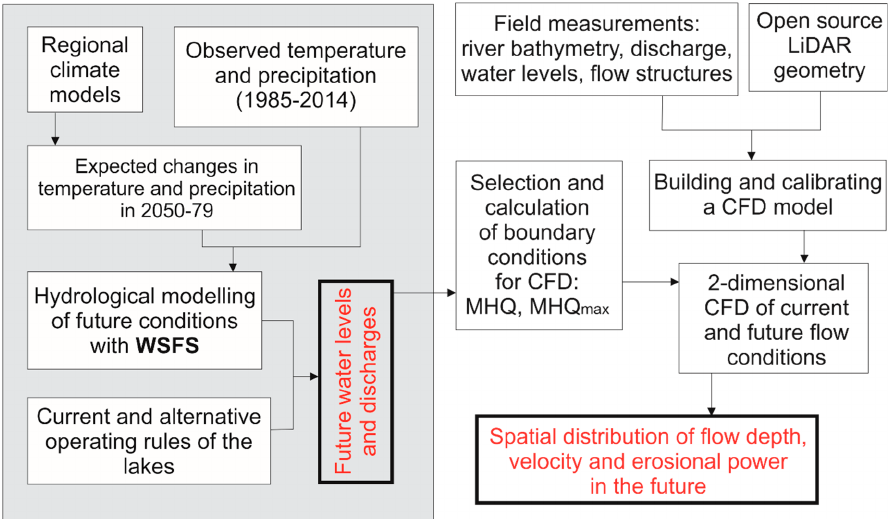
Figure 2. Data and workflow. The hydrological scenarios for the climate change period (2050–2079) and the alternative regulation strategies, produced by the Finnish Environment Institute and ELY Centres, were used as initial data (left) [51,72]. The WSFS stands for Watershed Simulation and Forecasting System. The work related to 2D hydraulic modeling of the flow characteristics (right) was performed in the current study. MHQ stands for the mean high